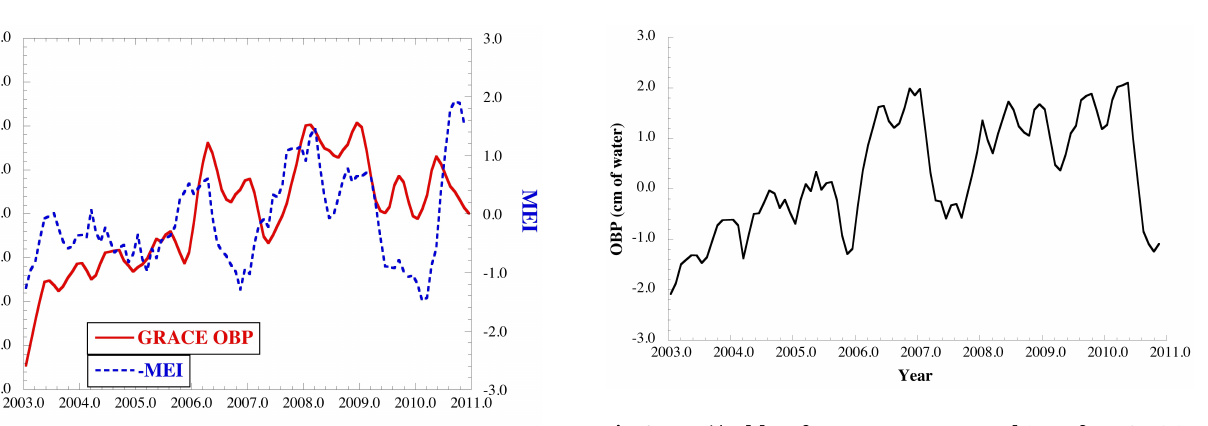
Fig. 9. Residual low-frequency, non-seasonal OBP from GRACE after removing ENSO-correlated variability from Fit 2 in Fig.